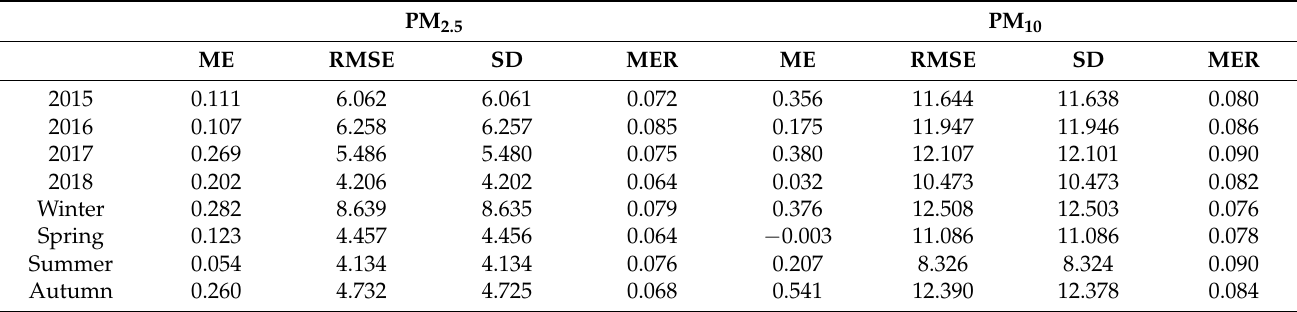
Table 2. Accuracy analysis of the selected spatial interpolation